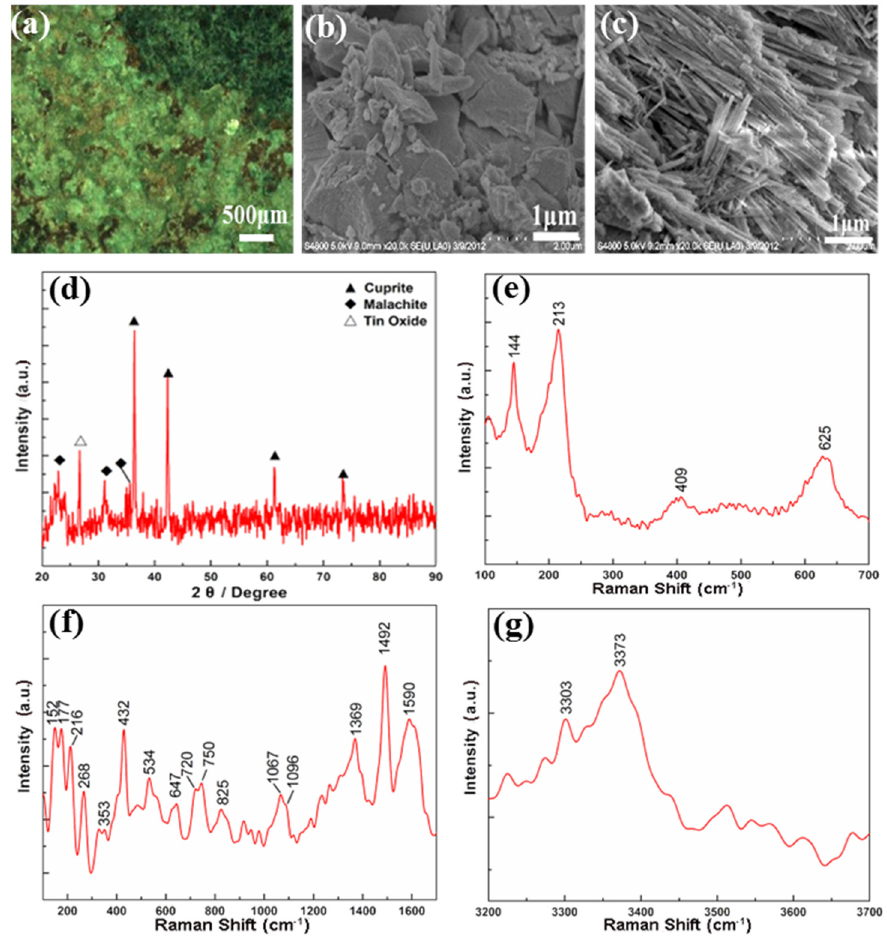
Figure 2. Characterizations of the corrosion products upon the bronze vase ( Gu ) (Shang Dynasty, collection No.: ABG-2209-1): ( a ) Optical image; ( b ) SEM morphology of the dark green corrosion; ( c ) SEM morphology of the light green corrosion; ( d ) XRD pattern; ( e ) Raman spectrum of the dark green corrosion; ( f , g ) Raman spectra of the light green corrosion in ranges 100–1700 cm − 1 and 3200–3700 cm − 1 , respectively.